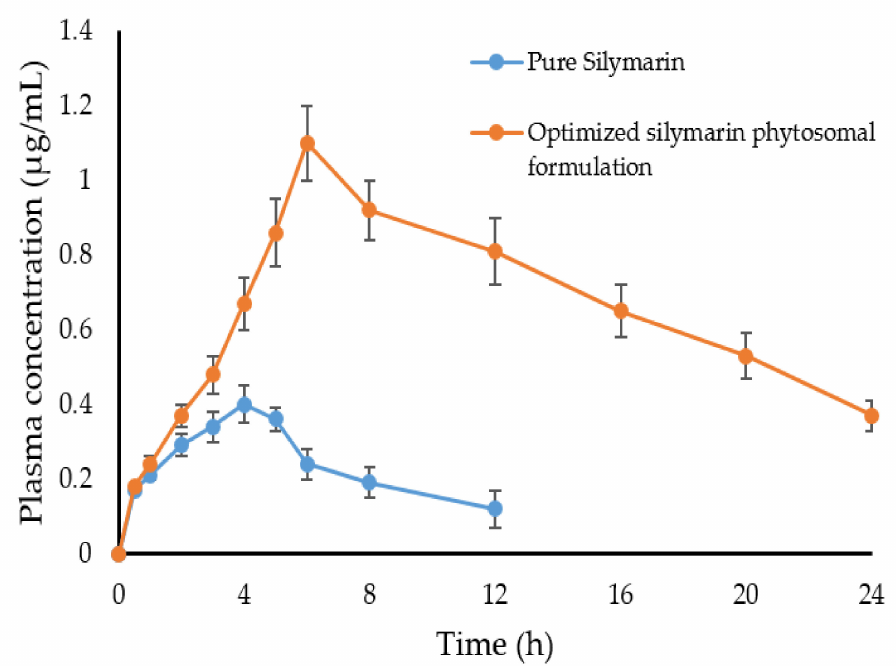
Figure 9. Mean plasma concentration-time profile of pure silymarin (100 mg/kg, p.o.) and optimized silymarin phytosomes (~100 mg/kg silymarin, p.o). Data are mean ± SD ( n =